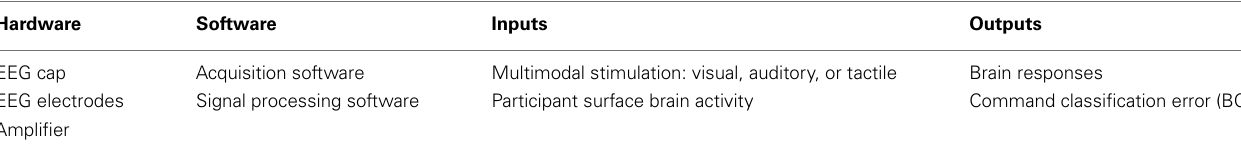
Table 6 | Characteristics of the EEG module .